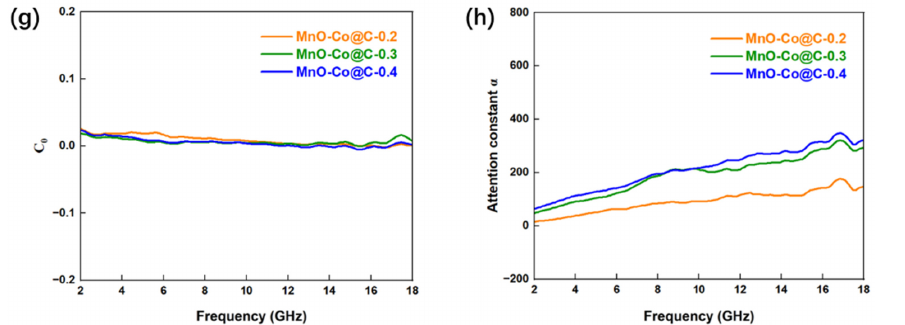
Figure 5. Electromagnetic parameters of MnO-Co@C-0.2, MnO-Co@C-0.3, and MnO-Co@C-0.4: ( a ) ε ‘, ( b ) ε ″ , ( c ) µ ’ ( d ) µ ″ , ( e ) the dielectric loss tangent factor tan δ ε , ( f ) the magnetic loss tangent factor tan δ µ , ( g ) C 0 , ( h ) attention constant α .